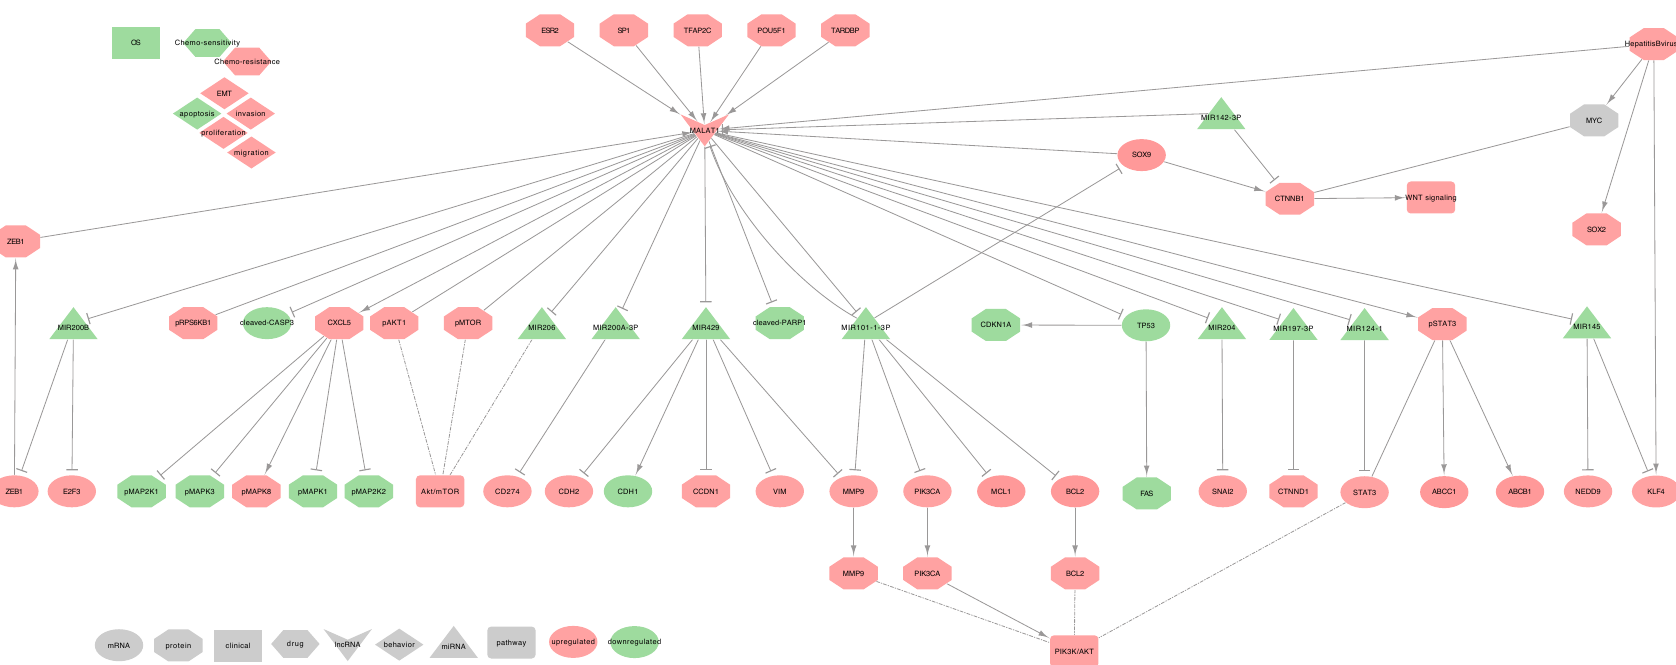
Figure 7. MALAT1 in lung cancers: A network of lncRNA-miRNA-Protein interactions. Upregulated molecules are in green. Downregulated molecules are in red. Shape definitions are in grey. Gray arrows target the activated molecules. T-ended lines target the inhibited molecules. Square-ended lines represent a binding between molecules. Dashed-dot lines represent an association with unknown